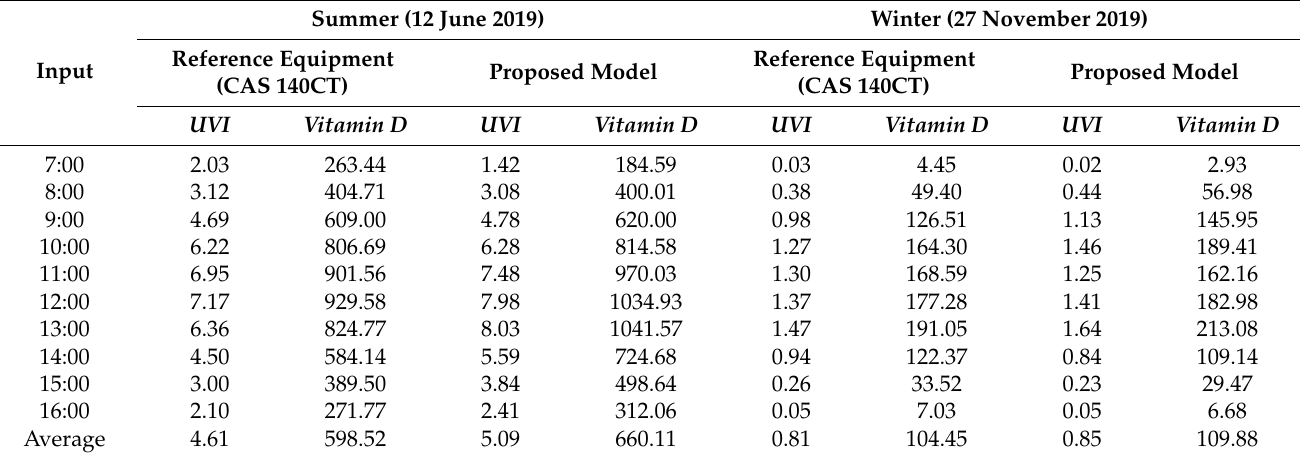
Table 3. Comparison of expected amount of vitamin D synthesis with the UVI calculation results (12 June 2019–27 November 2019).